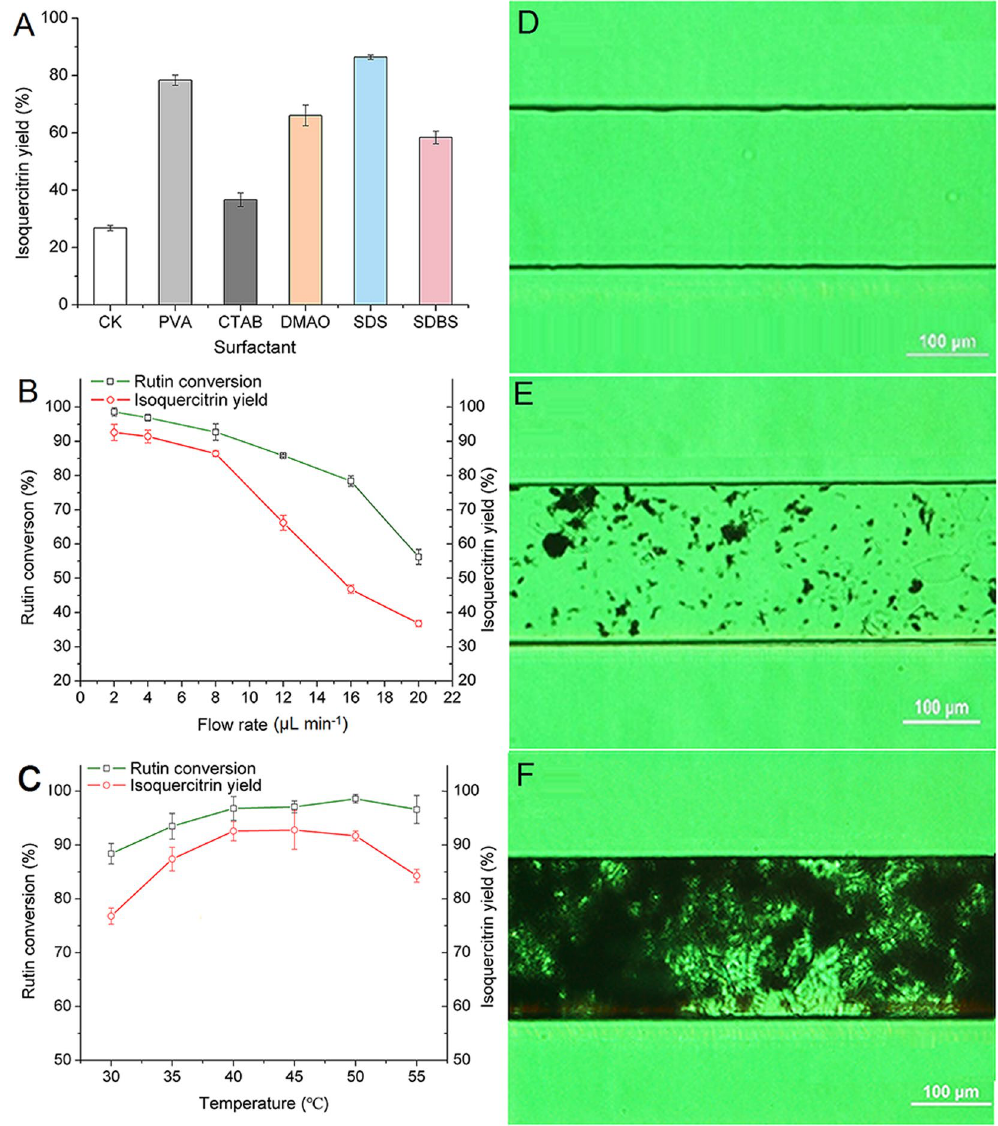
Figure 5. Effect of various reaction parameters on isoquercitrin yield in the microchannel reactor, including different surfactants ( A ), temperature ( B ) and flow rate ( C ). Reaction conditions: rutin concentration was 0.05 g/L. The real-time microchannel graph under inverted fluorescence microscope when inserting the reaction system in different stages; ( D ) before injecting graphene immobilized enzyme; ( E ) after injecting graphene immobilized enzyme for a moment; ( F ) stabilization after injecting graphene immobilized